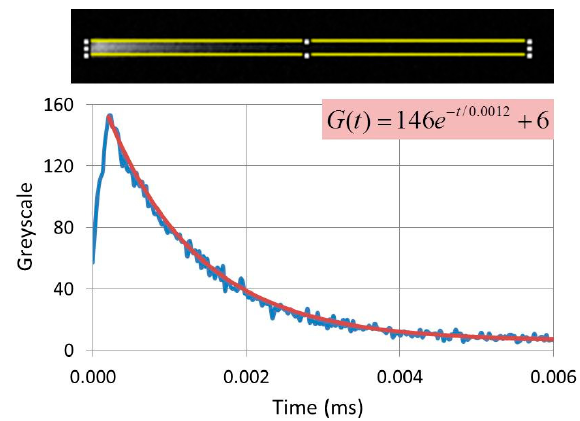
Figure 8. Determination of the decay time of commercial Y 2 O 3 :Eu 3+ (Nichia, with about 3 mol% Eu 3+ ) using ImageJ and curve fitting. Noisy curve is the experimental greyscale, while red curve is the fit. τ 1/e is 1.2 ms. Dwell time of the e ‐ beam on the Y 2 O 3 :Eu 3+ crystal about 250 μ s.